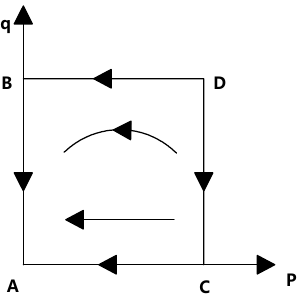
Figure 4. The evolution of phase diagrams in Case 1 ( p s ( 1 − γ ) − T > C r